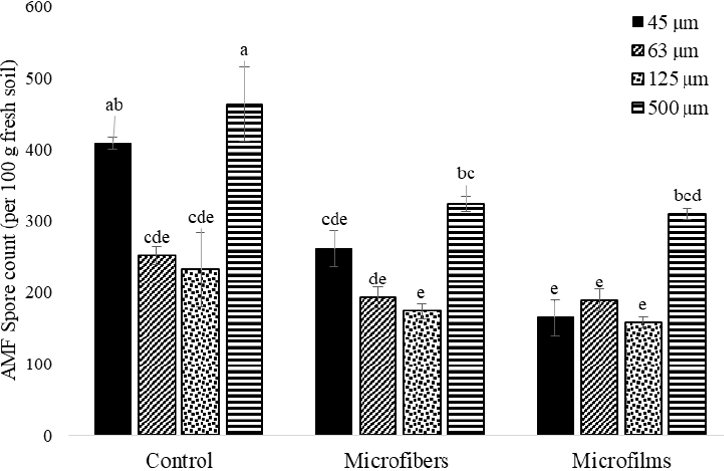
Figure 5: The AMF spore counts (number in 100 g of fresh soils) in soils with the highest MP concentration (8.4%) of microfiber and microfilms and soils without MPs (control). Error bars indicate the standard error of the mean value (SEM). Different letters indicate the significant differences (at a significance level of 0.05) between different spore size categories (45, 63, 125, and 500 µm) and treatments (8.4% MFB, 8.4% MFL, and